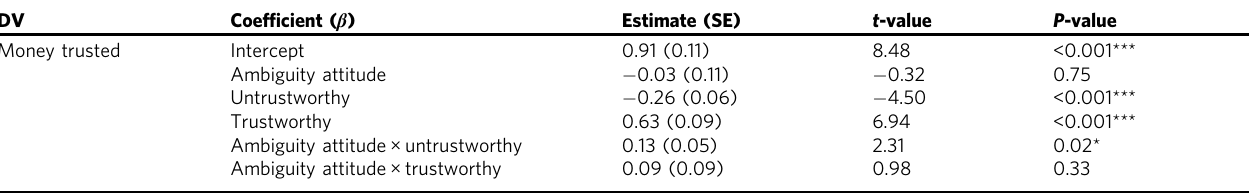
Table 2 Experiment 2: Ambiguity attitudes in the Trust Game DV